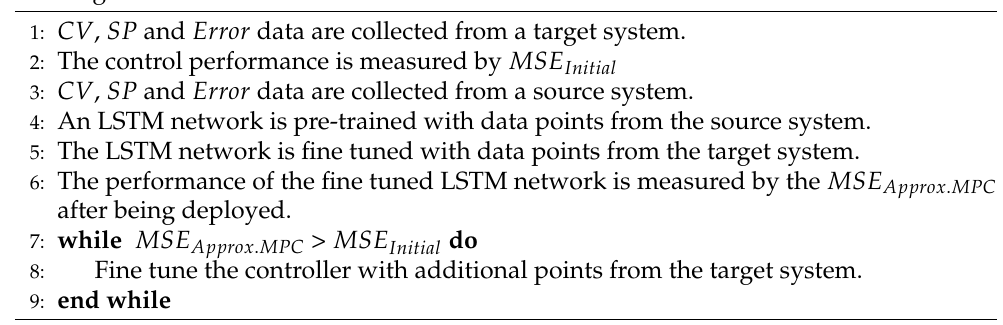
Figure 8. Validation fit after an LSTM network trained on source domain data is re-trained with 600 points of target domain data for 300 epochs. Algorithm 1 A framework for approximate MPC using LSTM networks and transfer